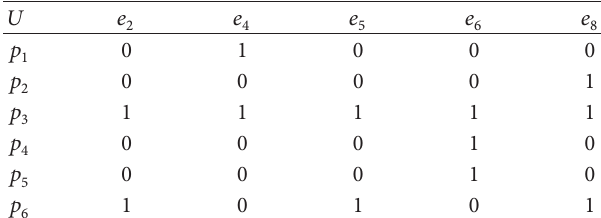
Table 3: Tabular representation of the soft set T 3 = 𝐿( S ;0.7) .